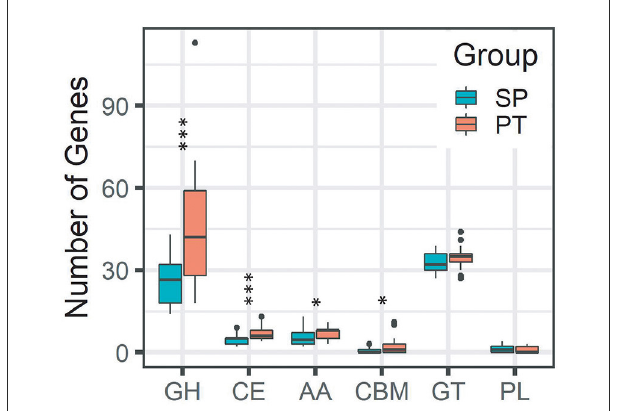
FIGURE3 Differences in the predicted CAZyme profiles between the SP and PT groups. Two groups were defined by the strains with T max ≤ 20 ◦ C (SP) and T max > 20 ◦ C (PT). *** P < 0.005; * P = 0.01–0.05. Enzyme classes: (GH), glycoside hydrolases; (CE), carbohydrate esterases; (AA), auxiliary activities; (CBM),carbohydrate-binding modules; glycosyltransferases, and (PL), polysaccharide